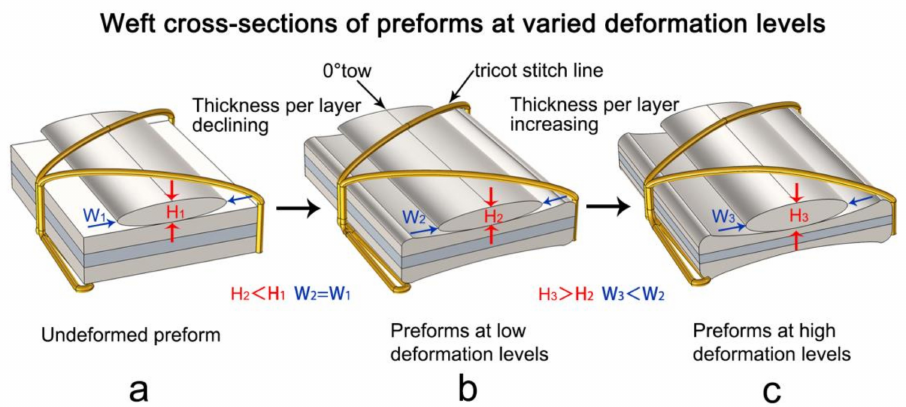
Figure 7. Weft cross-sections of quadriaxial NCF reinforced preforms at varied deformation levels. ( a ) undeformed preform; ( b ) preforms at low deformation levels; ( c ) preforms at high deformation